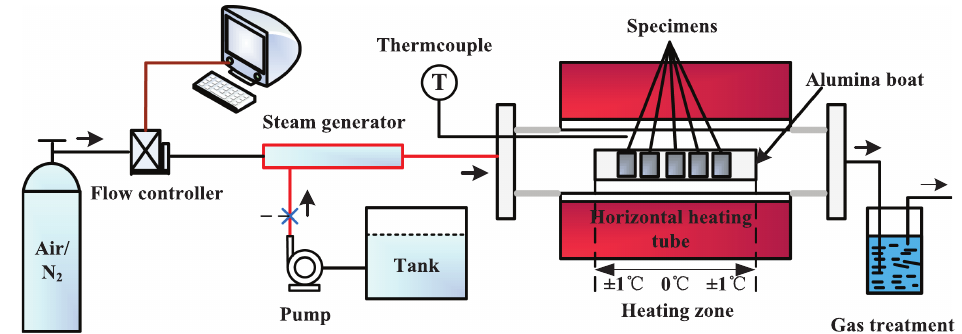
Figure 1: Schematic diagram of the steam oxidation system [12].